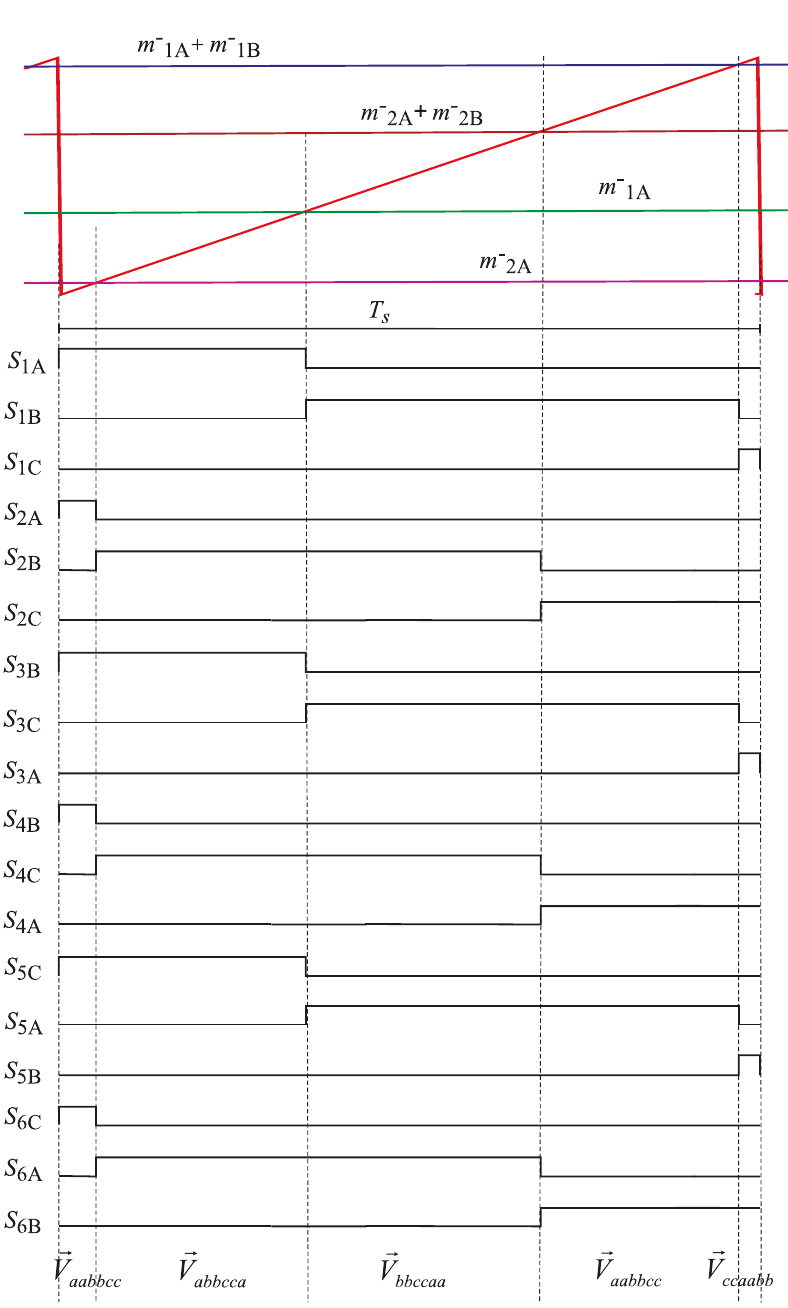
Figure 3. Switch duty cycles and rotating voltage space vectors of output voltage in three-to-six-phase MC for CCW type of space vectors.